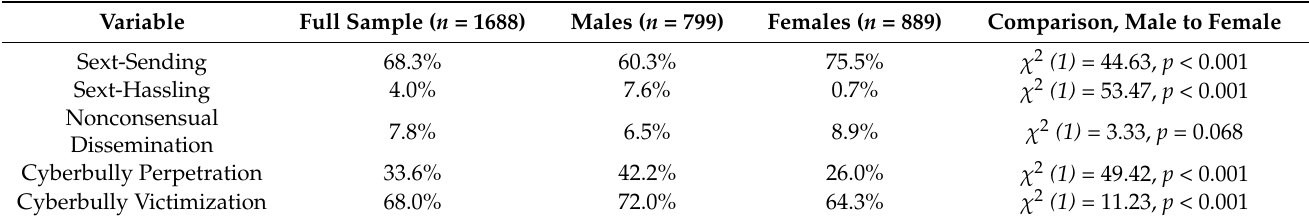
Table 1. Key Variables by Gender.